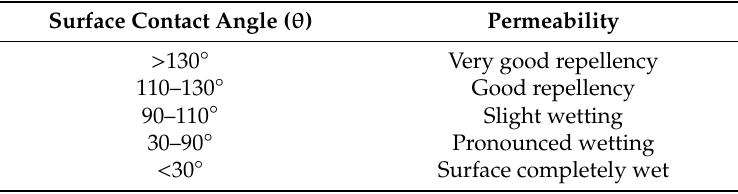
Table 7. Evaluation according to chloride ion permeability.